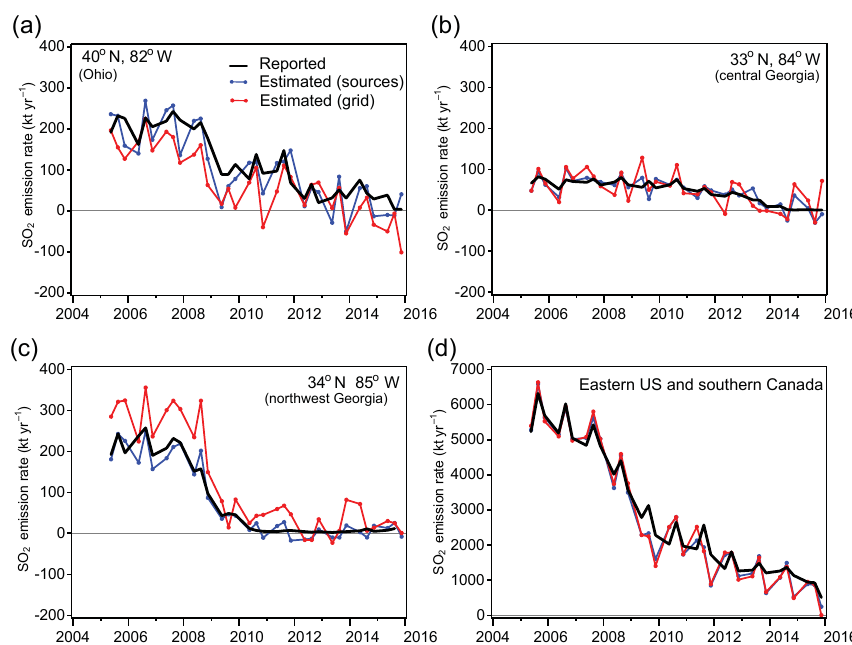
Figure 2. (a–c) Examples of reported and estimated seasonal emissions (in ktyr − 1 ) for three 1 ◦ by 1 ◦ grid cells as labelled on the plots. (d) Reported and estimated seasonal point-source emission rates for the entire eastern US and southeastern Canada (the region shown in Fig. 1) for spring, summer, and autumn. Estimated emissions are shown for the statistical model based on the actual source location (blue lines) and on a 0.5 ◦ by 0.5 ◦ regular grid (red lines). Note that the seasonal emission values are scaled to give annual emission rates. Winter data are not shown due to high uncertainties of OMI measurements.